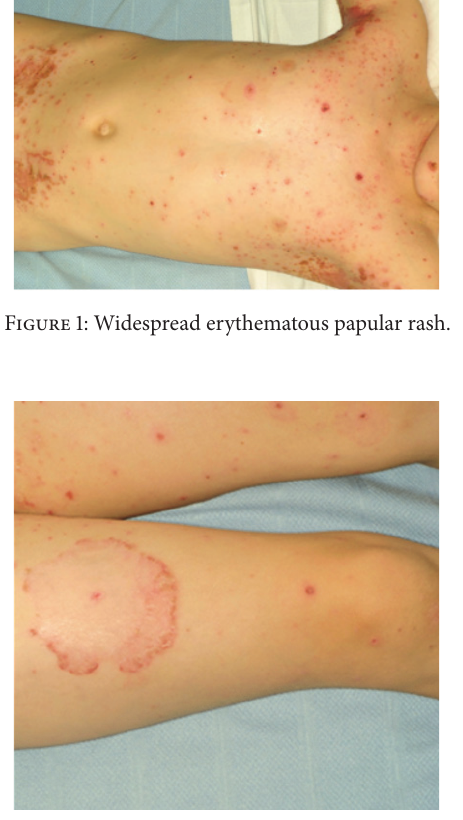
Figure 2: Annular lesion on right thigh with surrounding vesicles with “string of pearls”